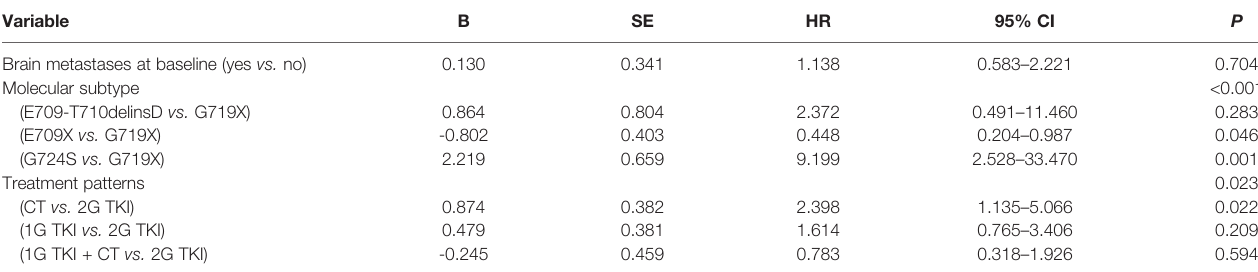
TABLE 5 | Predictors of PFS analyzed by multivariate Cox regression.